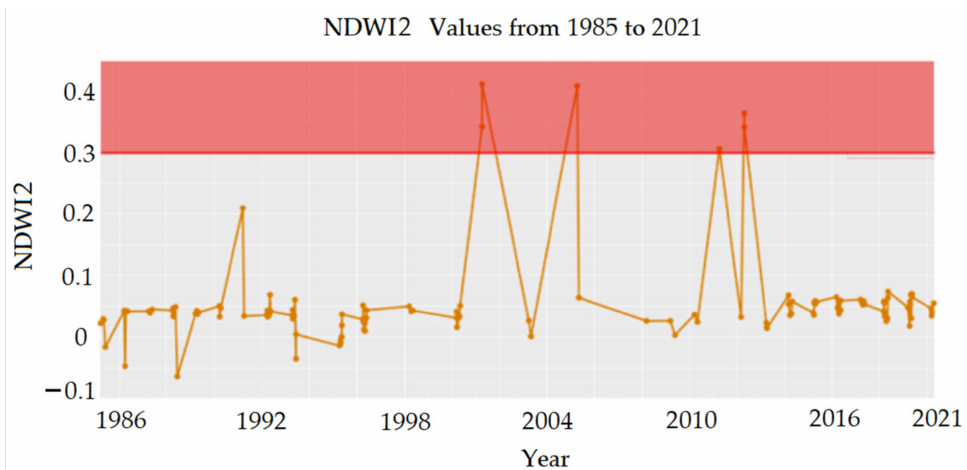
Figure 10. NDWI2 Values from 1985 to 2021.